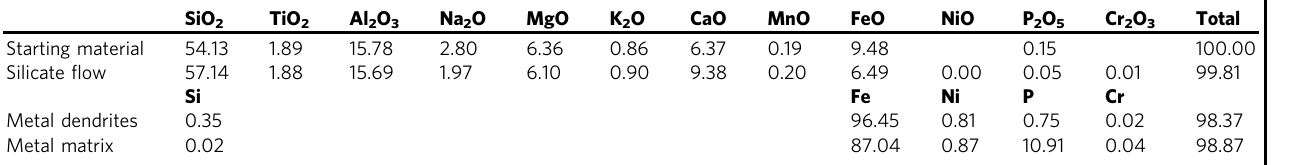
Table 1 Geochemical composition (wt%) of starting material and fl ow